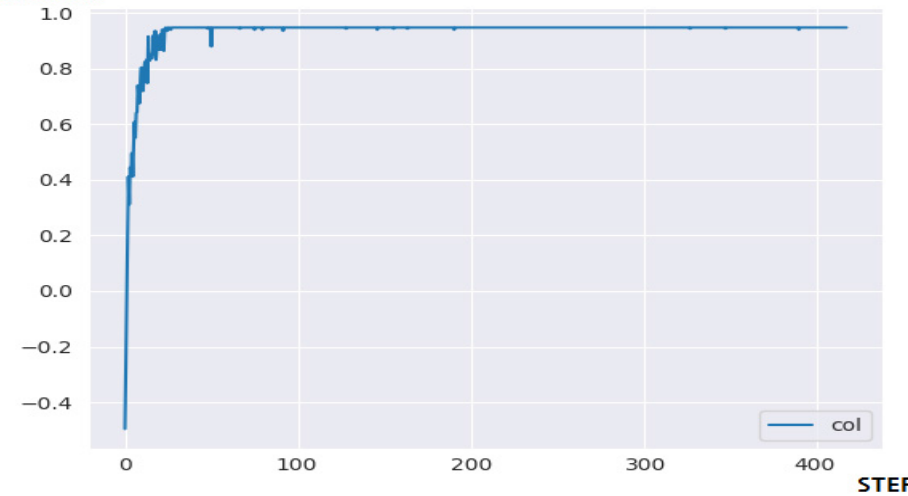
Figure 9. The result of a 5 × 5 maze game through DQN. These experimental results suggest that the cause of failure is that the process of se- lecting a learning sample from the replay buffer has randomness, and so the learning ef- ficiency is not good [6]. Additional implementations of algorithms that improve learning efficiency, or sequential removal of the oldest data from the replay buffer, will also signif- icantly improve performance. Figure 10 is the result of applying N-DQN to a 5 × 5 maze environment. In conclusion, the N-DQN solved the problem within the targeted 400 steps, and it shows stable performance after about 100 steps. Unlike DQN, since various perfor- mance improvement factors are implemented, the learning efficiency is very outstanding. However, problems with high H/W or resource occupancy occurring in parallelization of sublayers are identified. Q-Learning managed to solve the problem with the fewest steps and time. The 5 × 5 sized maze does not have many episodes, and there is a high proba- bility of obtaining a reward even for an unlearned action. In other words, it was judged that the difficulty of learning was too easy to draw a conclusion, so an additional experi- ment was conducted by further expanding the size of the maze. Table 4 summarizes 5 × 5 learning results.